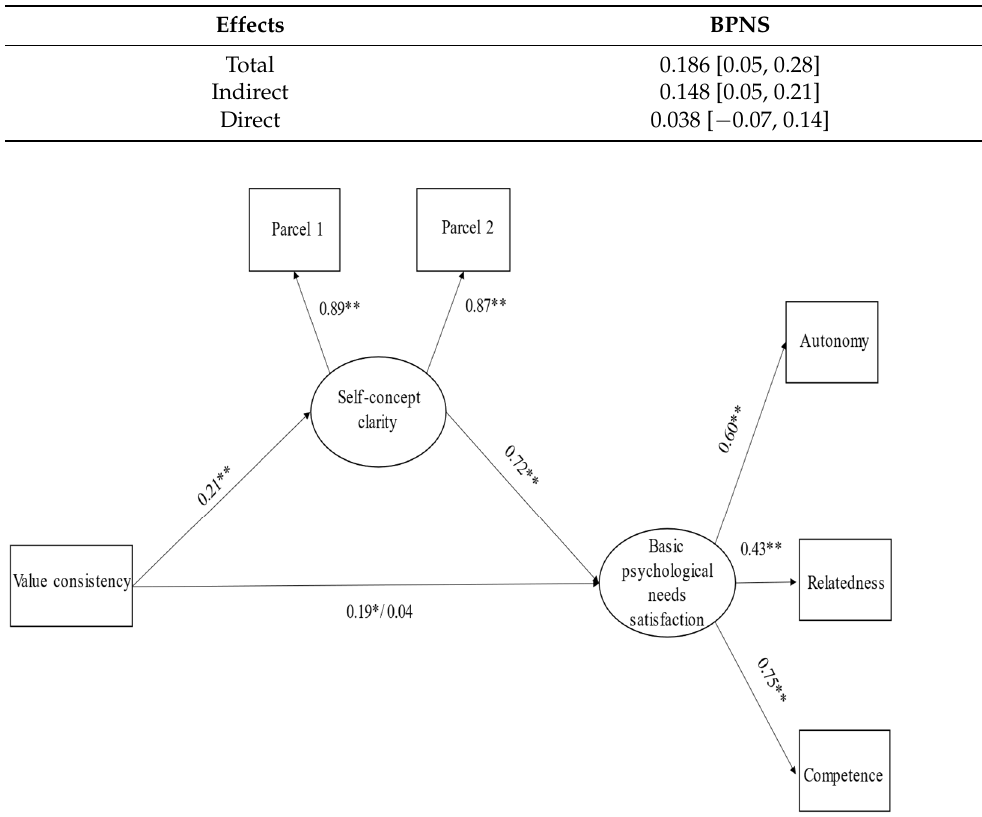
Figure 2. Structural mediation model with standardised effects. Note: ** p < 0.01, * p <